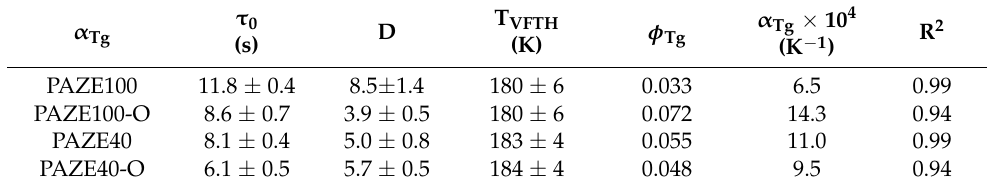
Table 3. VFTH parameters of α Tg relaxation for un-oriented and oriented PAZE100 and PAZE40. α